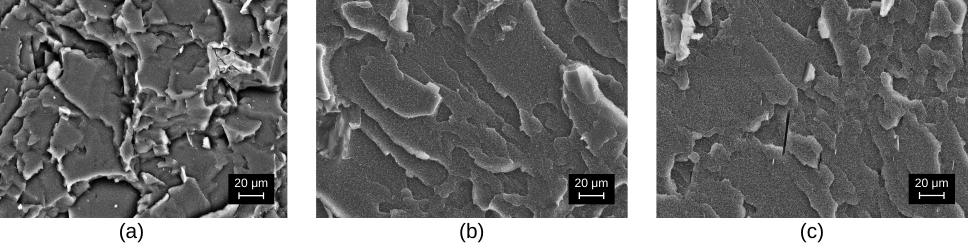
Figure 1. Cryo-SEM images of PS-based composites with binary fillers: C60 + Graphene ( a ), C60 + CNT ( b ) and CNT + Graphene ( c